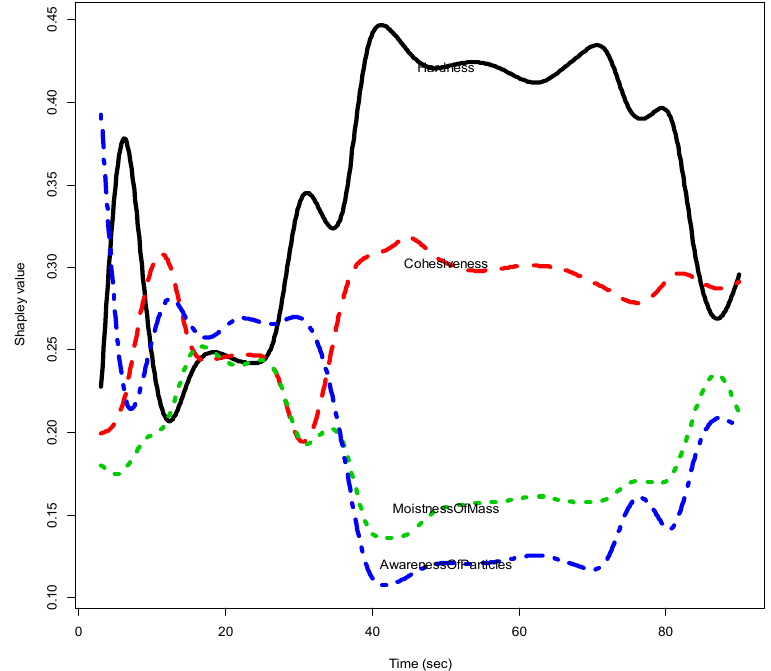
Figure 6. Temporal drivers of Overall Liking of Texture with line scale.